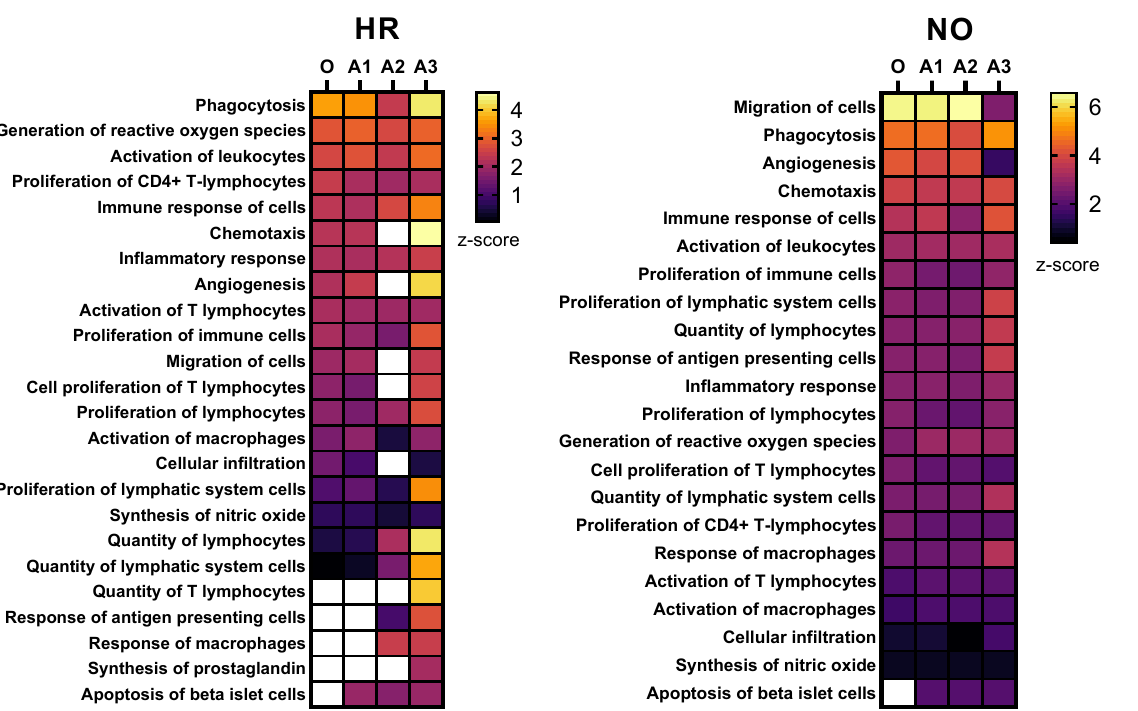
Figure 4. Heat maps showing selected immune functions identified in the integrated amplified proteomics and metabolomics datasets (A1, A2, and A3) in comparison to the original data (O) for both the HR and NO subject groups. Heat maps were generated based on the average z -score assigned by IPA to each predicted function in the metabolomics and proteomics datasets for both amplified and original datasets. Functions were sorted by the z -score for the original dataset. The z -score is a statistical measure that accounts for the directional effect of change and the magnitude of its impact on the affected disease/function (https://go.qiagen.com/IPA-transcriptomics-whitepaper, accessed on 27/August/2022). Functions were selected based on their direct involvement in inflammatory and immune responses and, hence, as relevant to T1D (see supplementary Tables S3 and S4 for complete lists of identified functions).